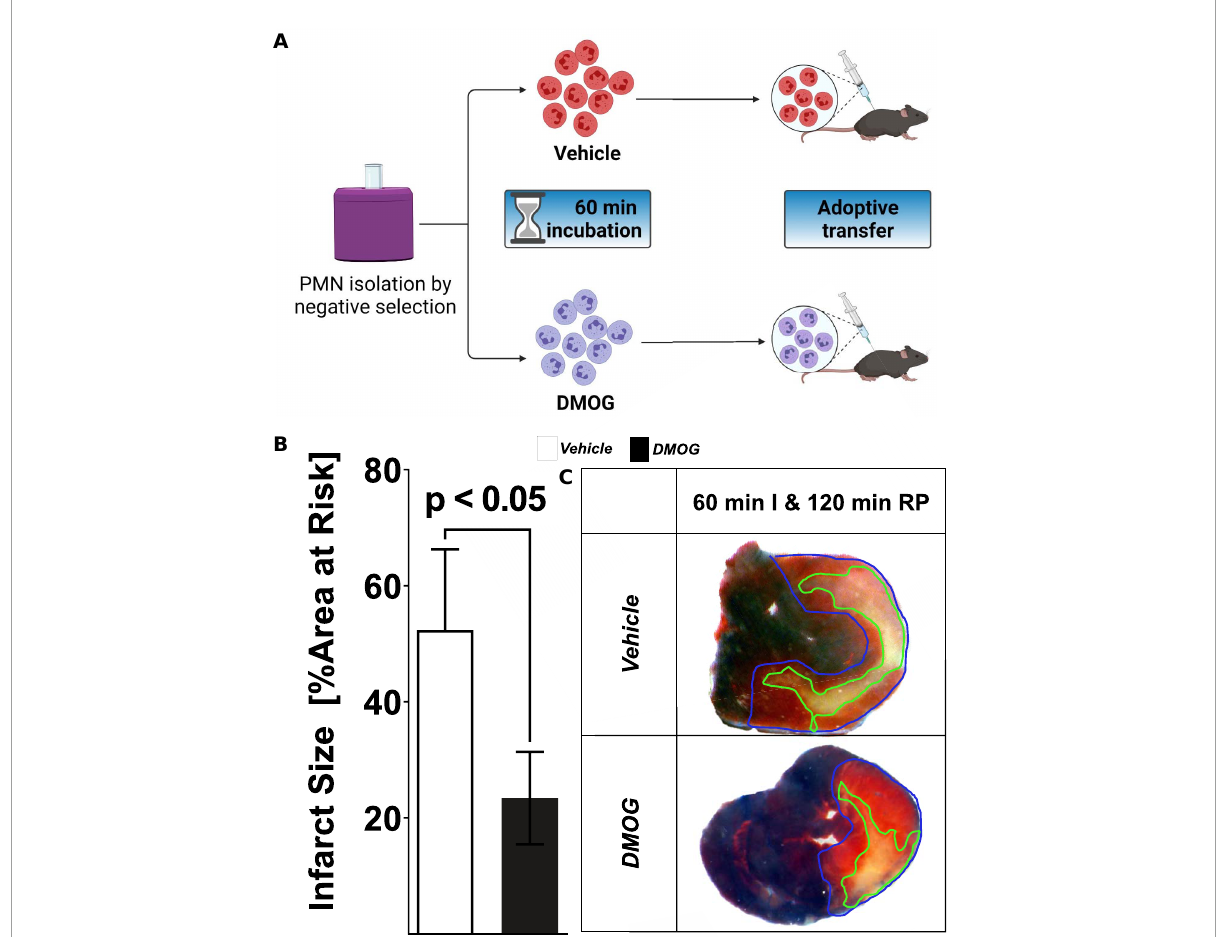
FIGURE4 Effect of HIF stabilization in PMN on myocardial injury. (A) Schematic of the pharmacological stabilization of HIF in PMN. Cells were harvested by negative selection from C57BL6 mice; isolated cells were incubated for 60 min in vehicle or 1 mM DMOG solution. The cells were then adoptively transferred to PMN-depleted C57BL6, treated with 1A8 Ly6G-specific antibody 24 h before the experiment. (B) Infarct sizes ± SD in mice receiving vehicle or DMOG treated PMNs presented as percentage to the area-at-risk after 60 min of ischemia, followed by 120 min of reperfusion (vehicle n = 5; DMOG n = 4; all values represented as mean ± SD; statistical significance assessed by two-sided, unpaired Student’s t -test). (C) Representative infarct staining from neutrophil-depleted mice receiving PMN treated with DMOG or